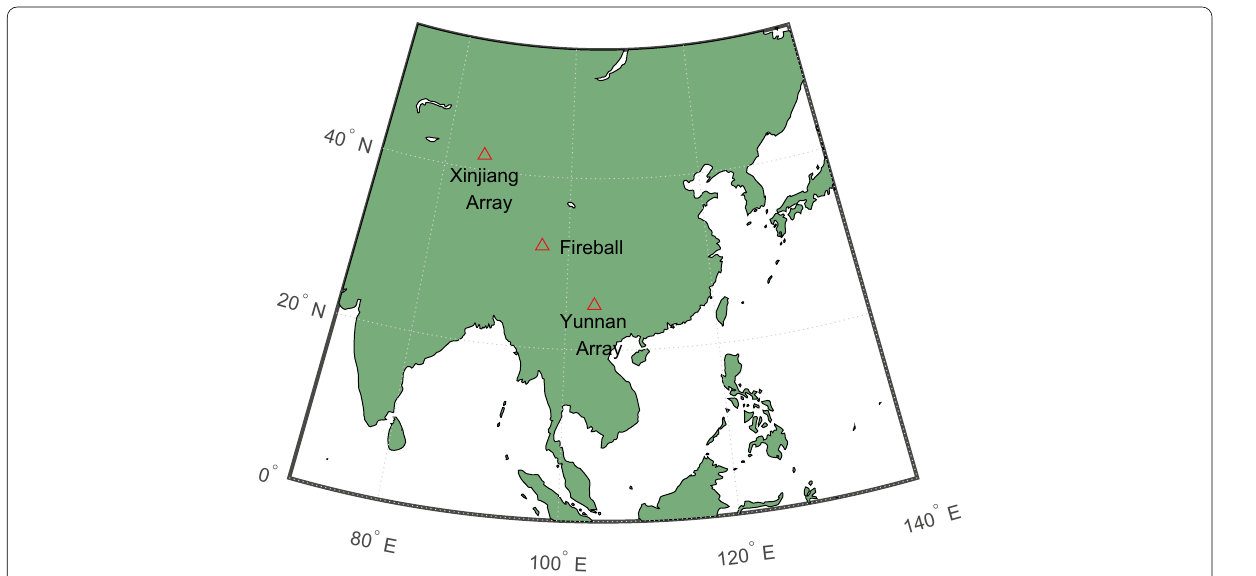
Fig. 1 Map. Locations of the infrasound station in Yunnan Province and the fireball